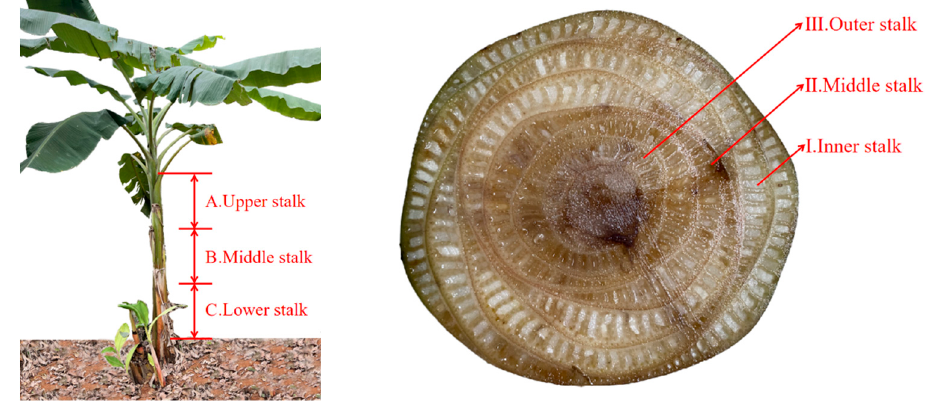
Figure 1. Sampling and Marking of Banana Stalks.